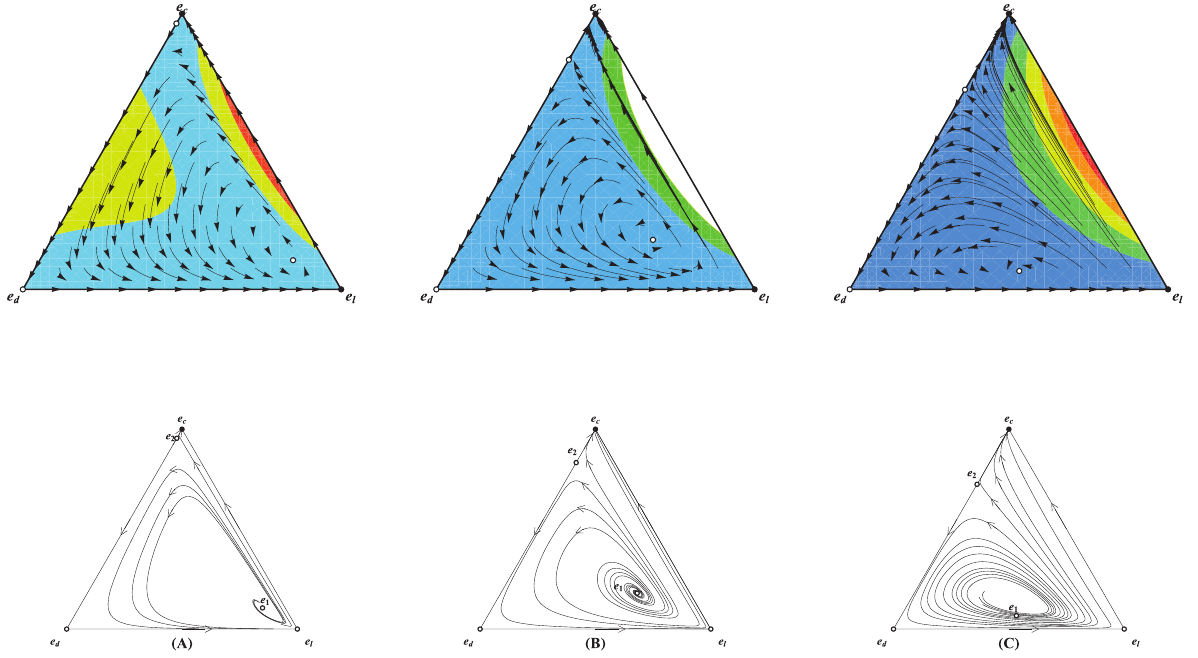
Figure 5. Triangle plots illustrating the population dynamics for defectors ( e d ), cooperators ( e c ) and loners ( e l ) for trajectories starting from all possible initial frequencies for the inverse-sigmoidal risk removal pattern. Each vertex represents a homogeneous population of that pure strategy. ( A ) For small interest rate r , except for the unique nontrivial fixed point ( i : e : , e 1 ) located inside the simplex S 3 , there also exists another nontrivial fixed point located in the line e c e d ( i : e : , e 2 ). In consequence, the inside area of the simplex S 3 is divided into two attraction basins, with one being loners’ and the other cooperators’. ( B ) For modest r , e 1 and e 2 as in plot ( A ) still exist. Instead the cooperators’ attraction basin covers absolutely large fraction of the inside area of the simplex S 3 , and loners win the evolution for population starting from the remaining area. If defectors are abundant, the population converges to the full cooperative state in a spiral way around the unstable fixed point e 1 . Otherwise, the population directly drives towards e c . ( C ) Further increase in r continue to expand the cooperators’ attraction basin. It should be noted that even r ~ N , the attraction basin albeit narrow does not vanish. Relevant parameters N ~ 10 , m ~{ 0 : 4 and ( A ) r ~ 3 , ( B ) r ~ 6 , ( C ) r ~ 10 .